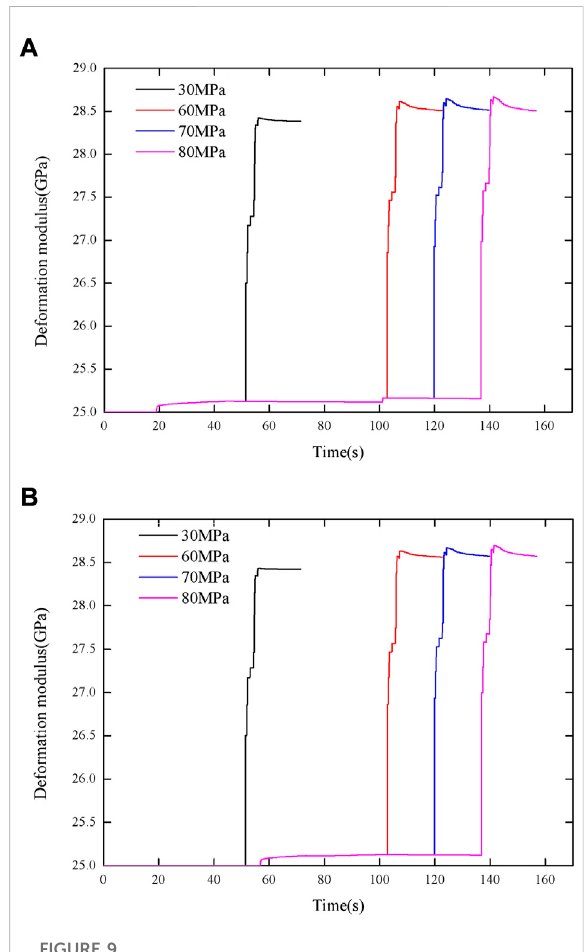
FIGURE 9 Thevariation indeformationmodulusoftherockunderKobe seismic load with maximum stresses: (A) Triaxial loading with con fi ning pressure of 5 MPa; (B) Triaxial loading with con fi ning pressure of 15